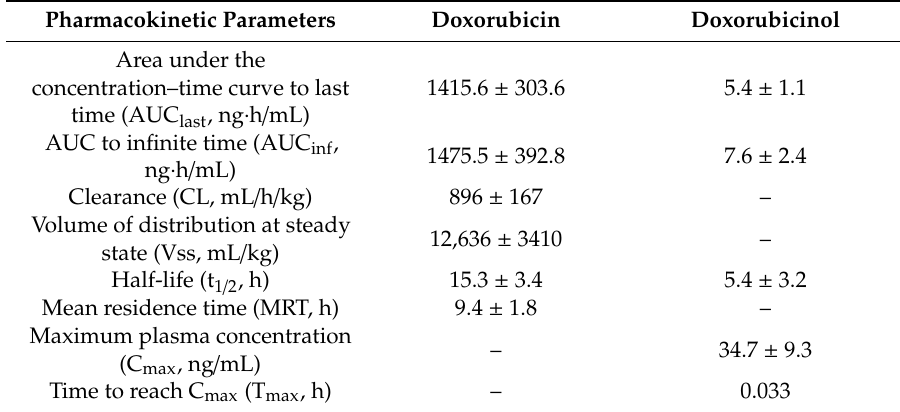
Table 4. Pharmacokinetic parameters of doxorubicin and its metabolite doxorubicinol after a single intravenous injection of doxorubicin at a dose of 1.3 mg / kg to female BALB / c nude mice. Data are shown as means ± SDs ( n =